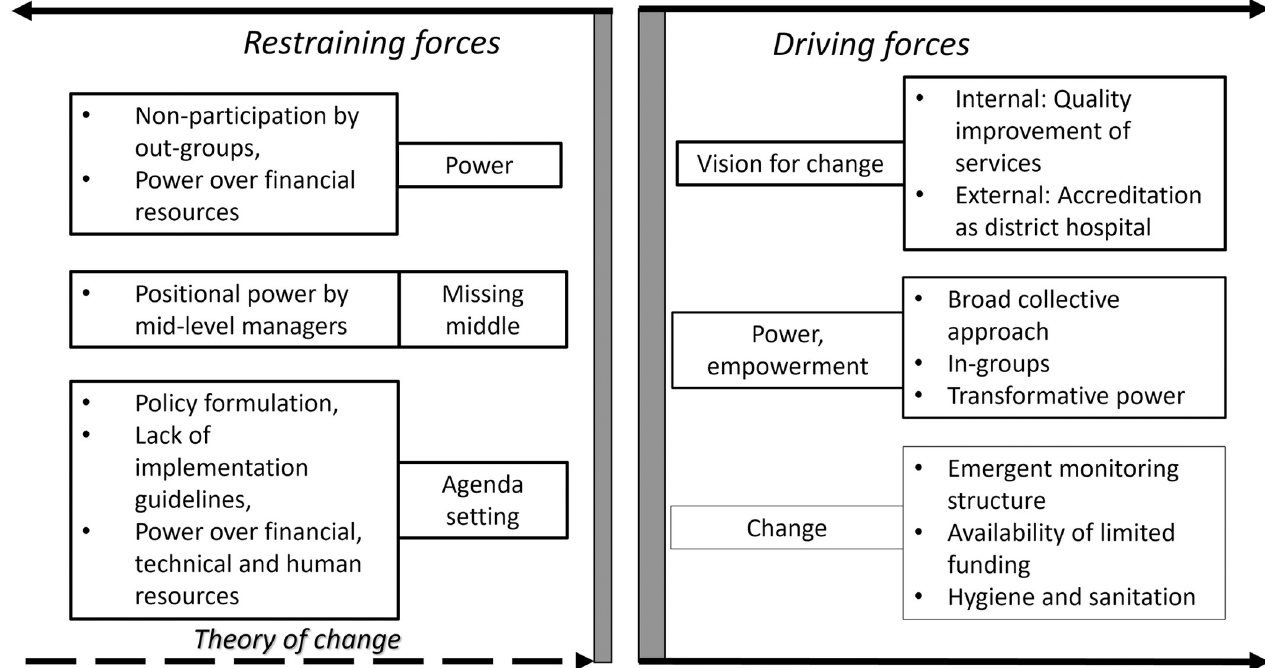
Fig 1. Restraining and driving forces. The above figure indicates the restraining and driving forces of the National Health Services Standards implementation process. On the left there are set of restraining forces and on the right are the set of driving forces. The two vertical lines in the middle demonstrate the gap created by the opposite directions of the